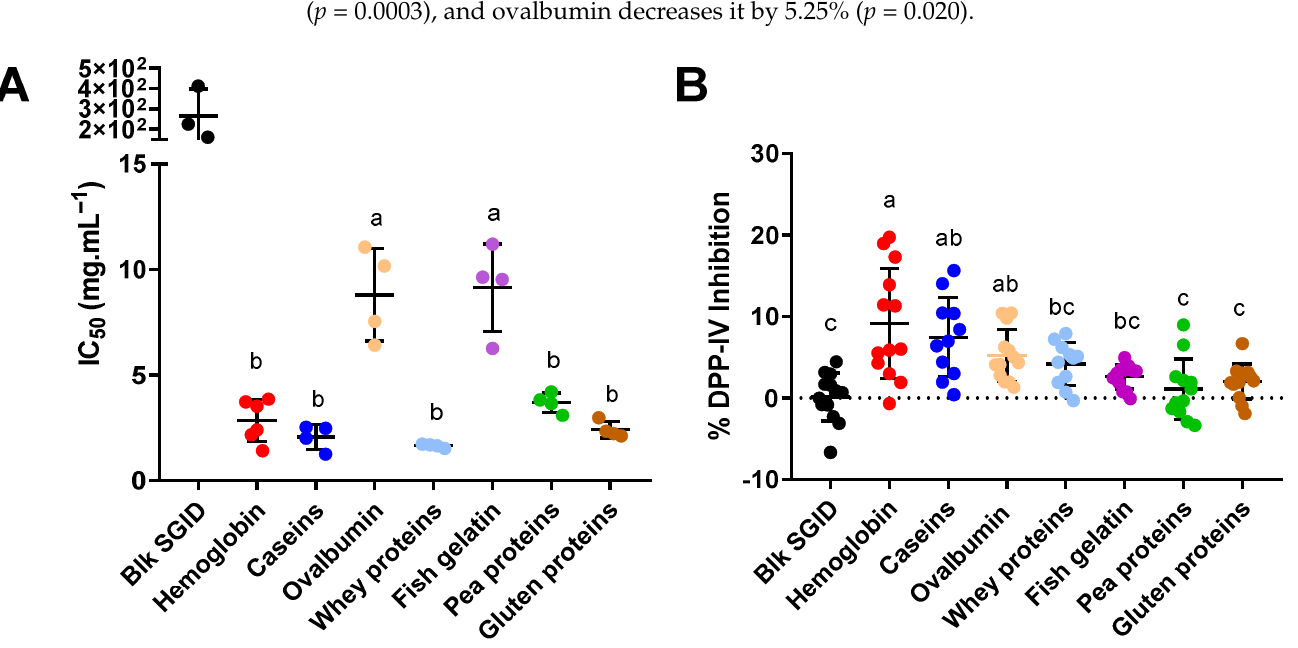
Figure 3. Digested proteins exert different DPP-IV-inhibitory activity in intestinal cells (Caco-2)